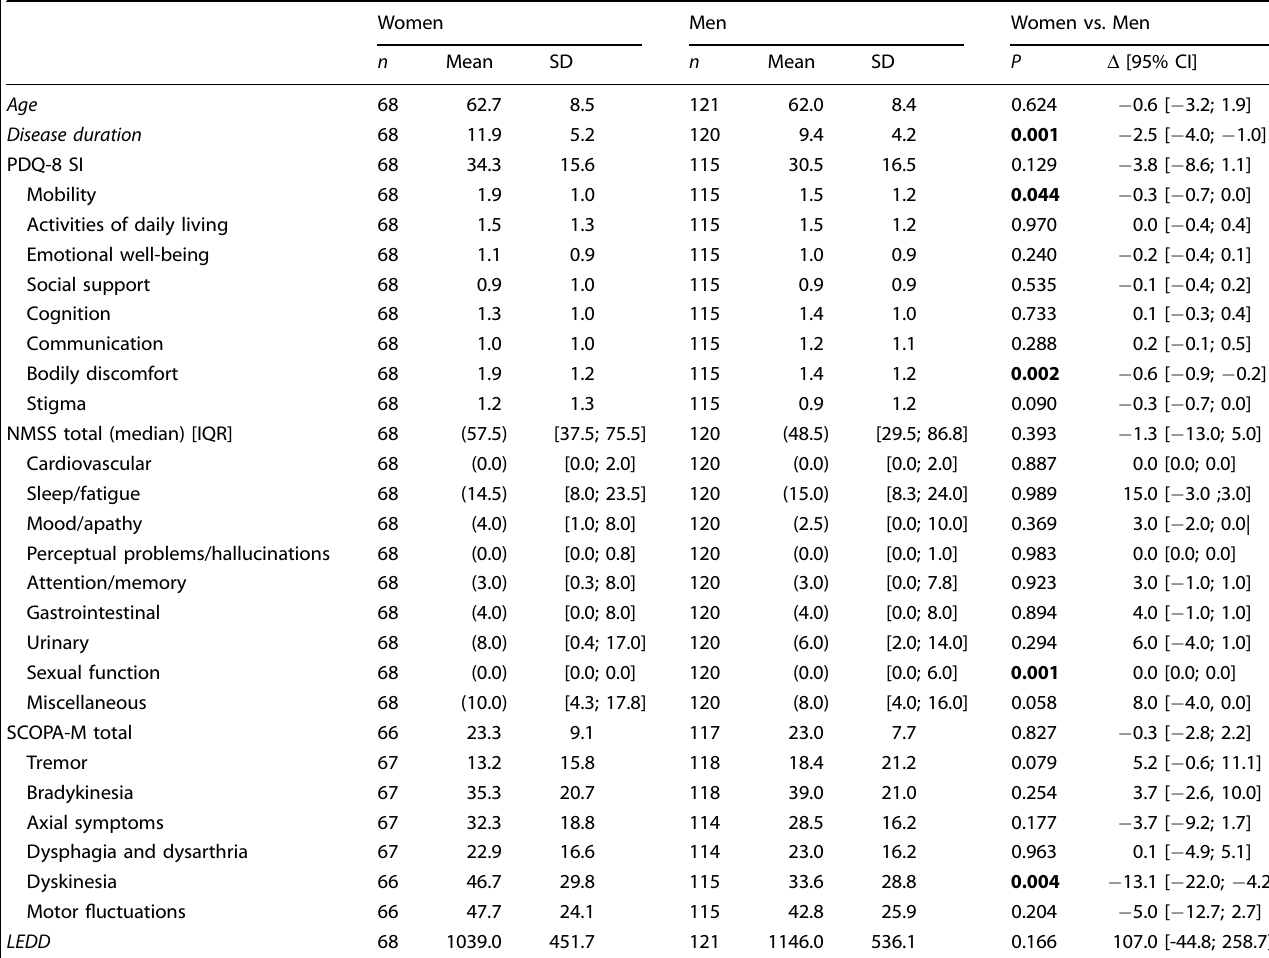
Table 2. Baseline characteristics of women and men with Parkinson ’ s disease in the original longitudinal